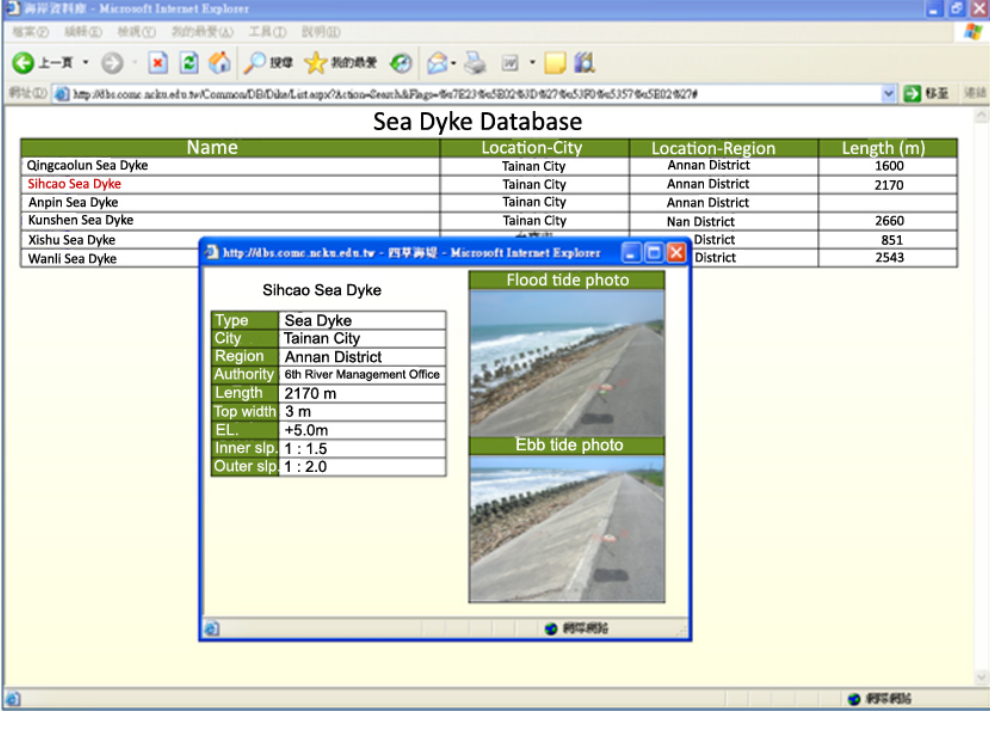
Figure 14 Window of detail data of queried sea dyke Fig. 14. Window of detail data of queried sea dyke.